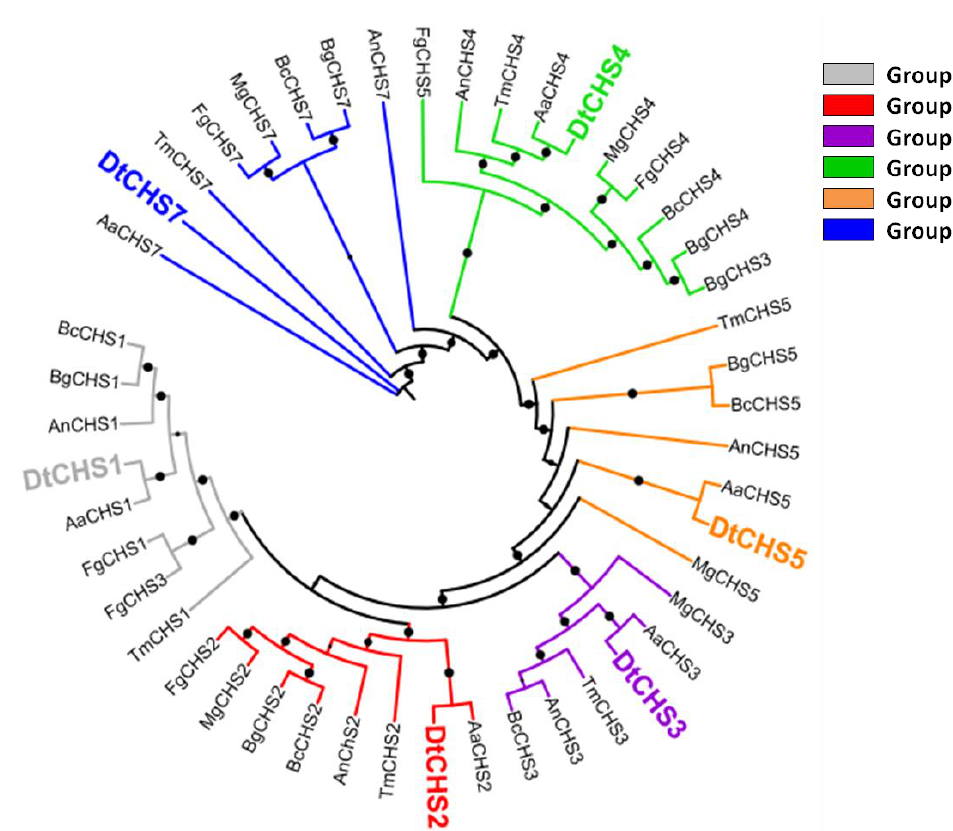
Figure 2. Maximum likelihood phylogenetic tree (bootstraps: 100) of chitin synthases (CHS) from D. teres ( Dt ), A. nidulans ( An ), A. alternata ( Aa ), B. cinerea ( Bc ), B. graminis ( Bg ), F. graminearum ( Fg ), T. melanosporum (Tm ) and M. grisea ( Mg ). The protein accession numbers are indicated in Table 2. Bootstraps > 80% are represented as black circles on the branches. The bootstrap % value increases with the circle size.